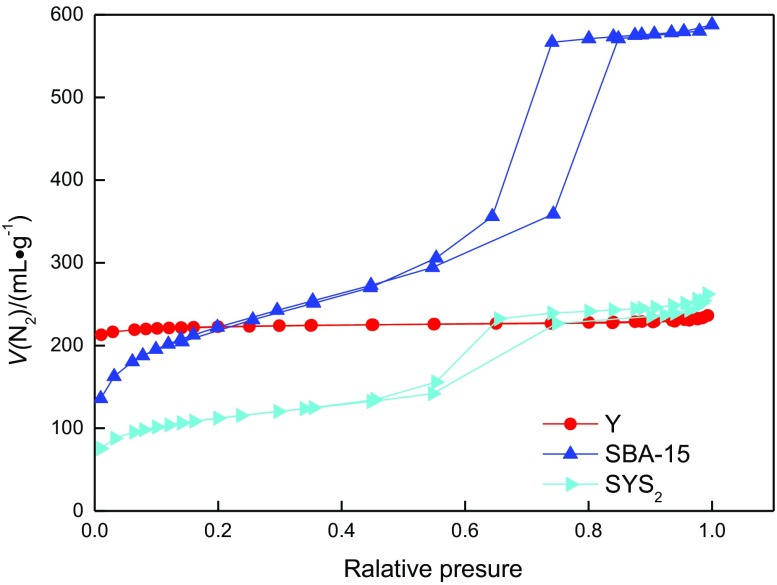
N2 adsorption–desorption isotherms of Y, SBA-15, and SYS2.